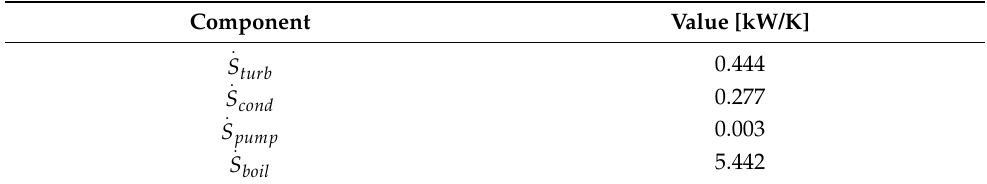
Table 3. Entropies change rates of the main components of the Organic Rankine